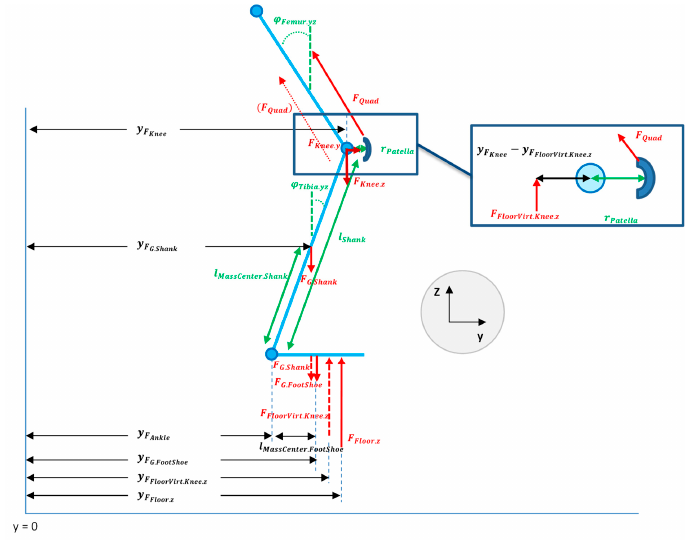
Figure A2. Calculation of knee joint forces.